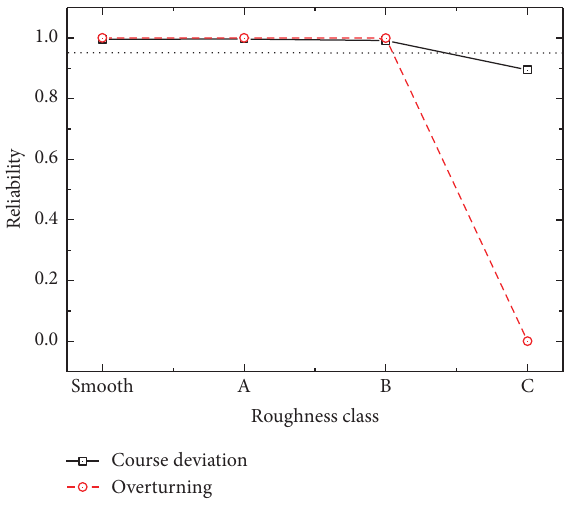
Figure 9: Reliability with roughness level.